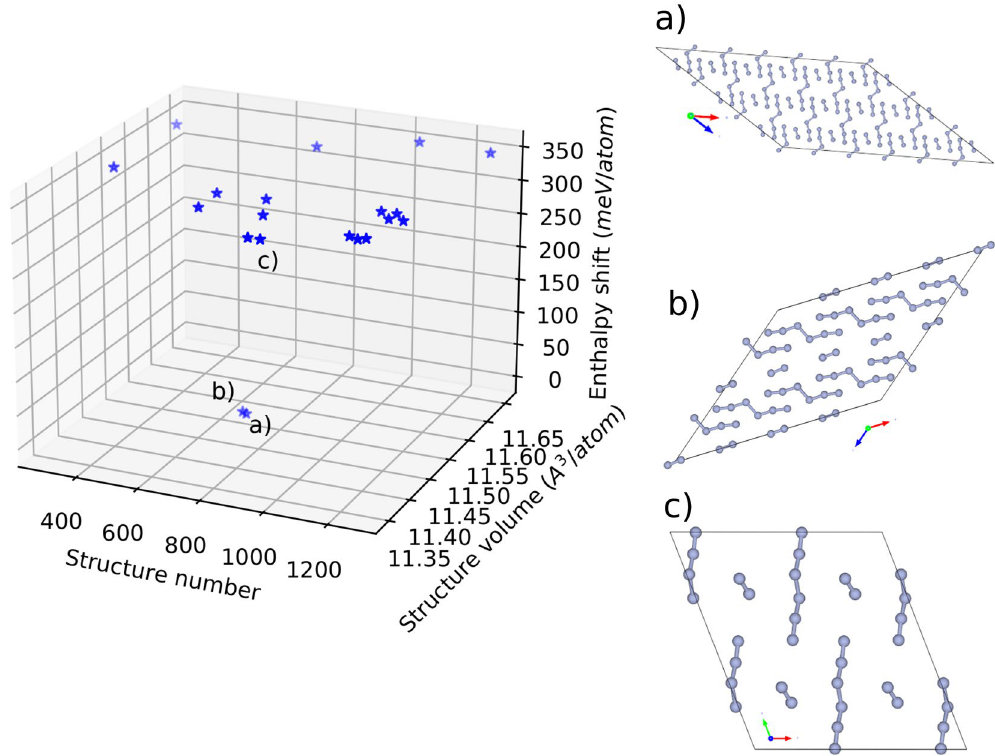
Figure 2. Results of the evolutionary search with USPEX in combination with Quantum Espresso DFT engine for geometry optimization. 41 Generations for a total of 1292 crystal structures were produced for optimization. The best 20 structures were plotted against their structure number along the search, their corresponding volume and enthalpy. Ball and stick representation of the best 3 structures ( a , b and c ) are presented along with their position in the enthalpy/volume V-H landscape. The enthalpy shift is from the best structure (structure a)) in